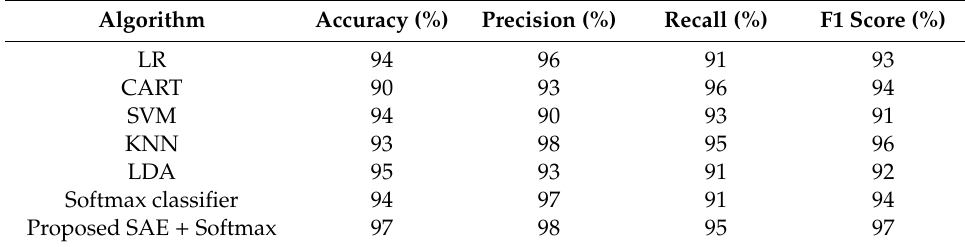
Table 2. Performance of the proposed method and other classifiers on the cervical cancer dataset.